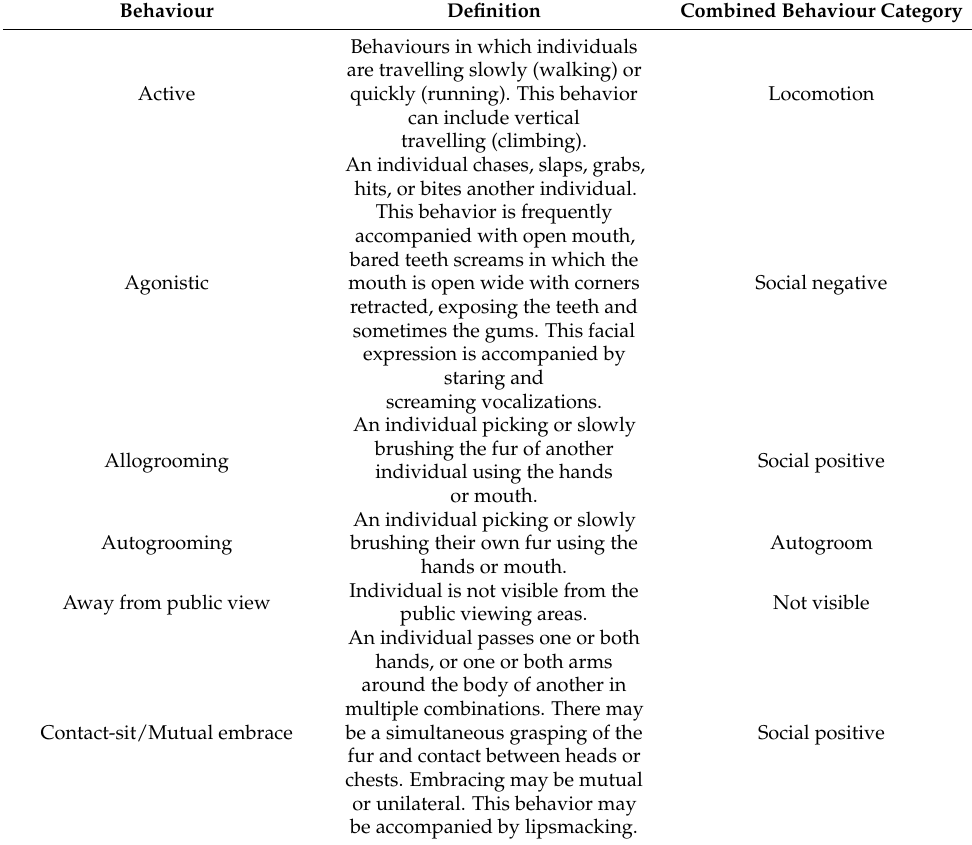
Table A2. Crested macaque ( Macaca nigra ) sub-project